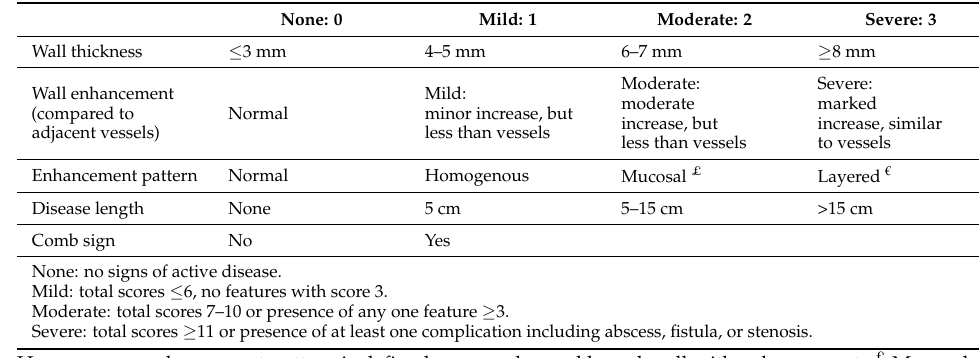
Table 1. Modified CT scoring